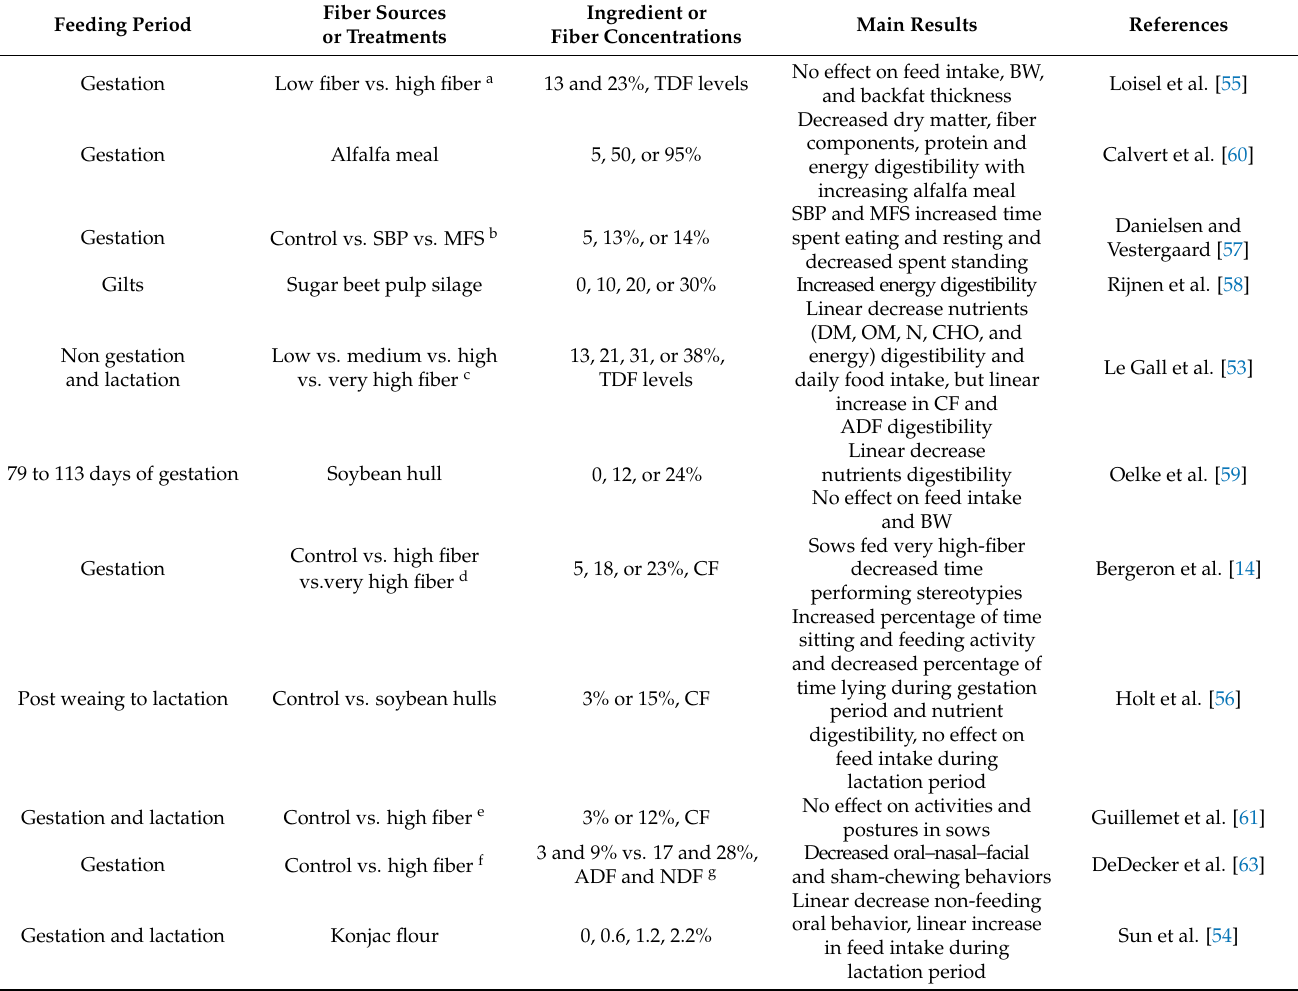
Table 5. Results of studies evaluating the effect of various levels of dietary fiber on feed intake, nutrient digestibility, and behaviors of